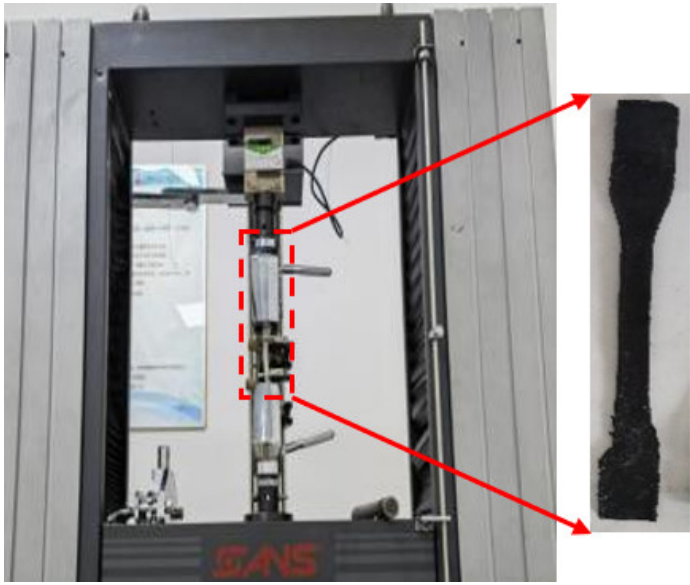
Figure 1. Tensile test.